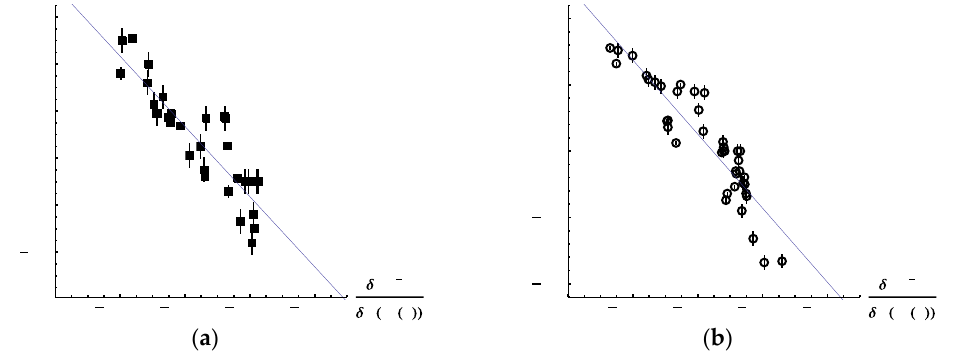
Figure 10. Correlation between Hammett constants and δ B O-H / δ v(H(4)) values at the B3LYP/6-311G** level. ( a ) Meta-substituted benzoic acids; ( b ) Para-substituted benzoic acids. When considering the reason why the linear relationships hold, it is noteworthy that n K logK ( n = m or p ) is proportional to the difference between the changes of the Gibb’s energies X 0 for the acid dissociation reactions of the non-substituted and the substituted benzoic acids, i.e.,